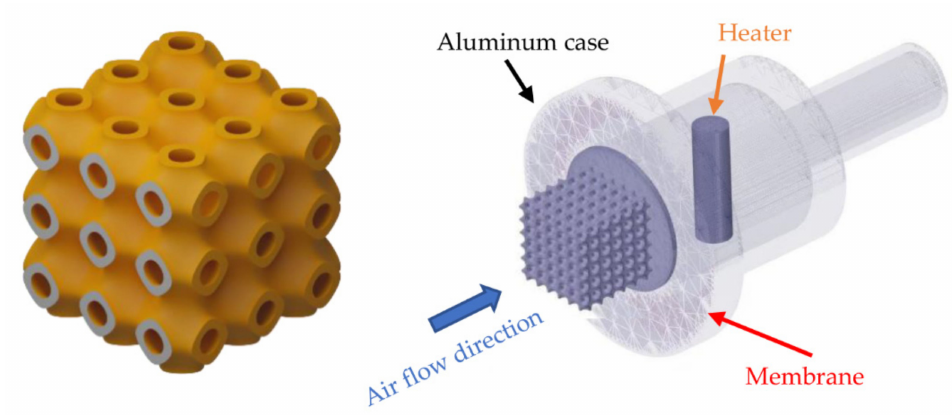
Figure 12. TPMS-air contact area of Primitive as an example.